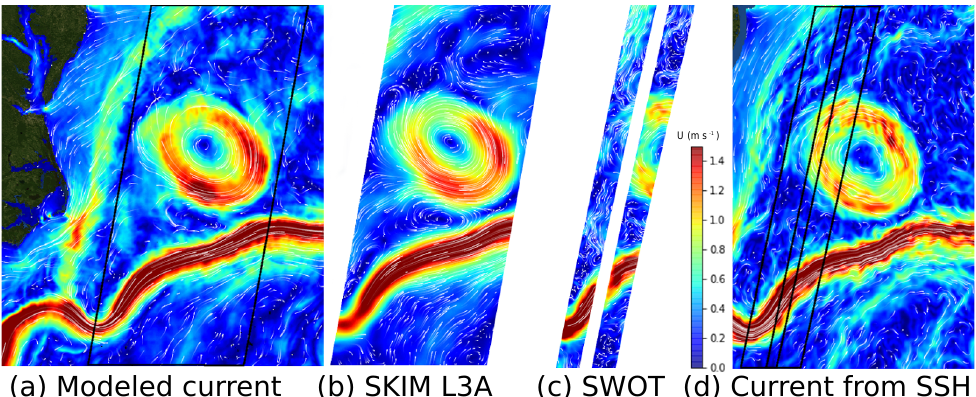
Figure 9. Simulated ocean currents over the Gulf Stream, and associated SKIM and SWOT simulated observations for a single satellite pass.